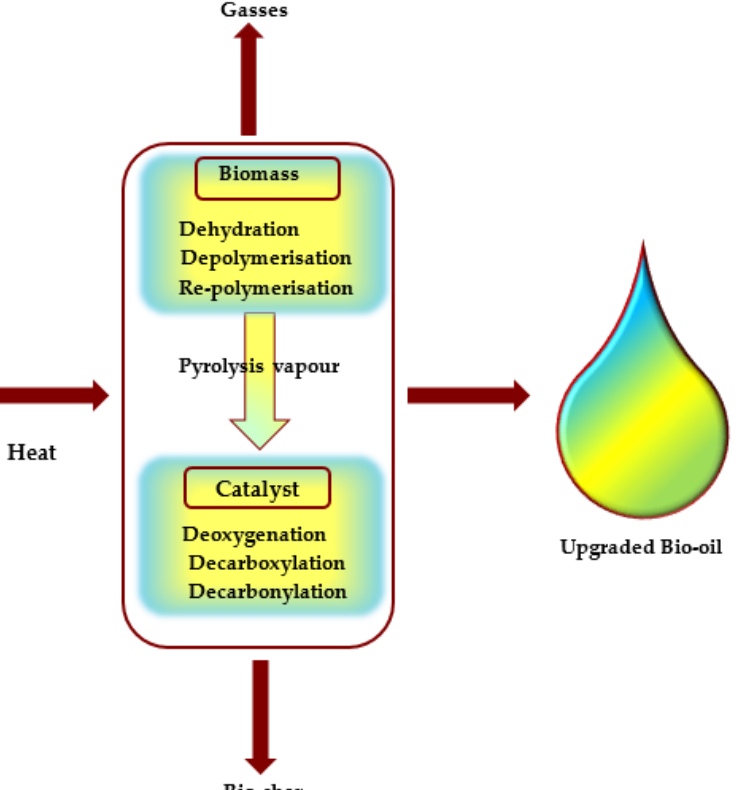
Figure 18. General catalytic pyrolysis pathway (adapted from [155]).